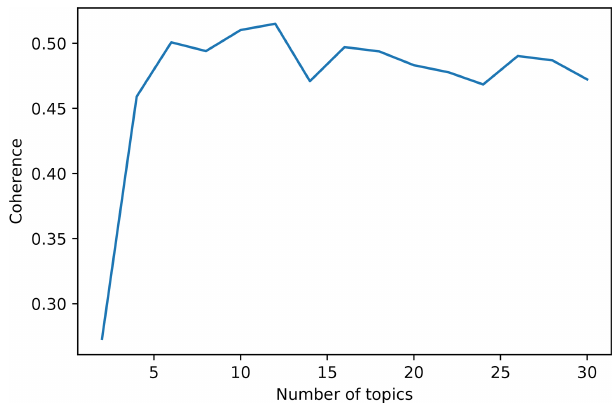
Figure 8. Coherence by number of topics used to train a LDA